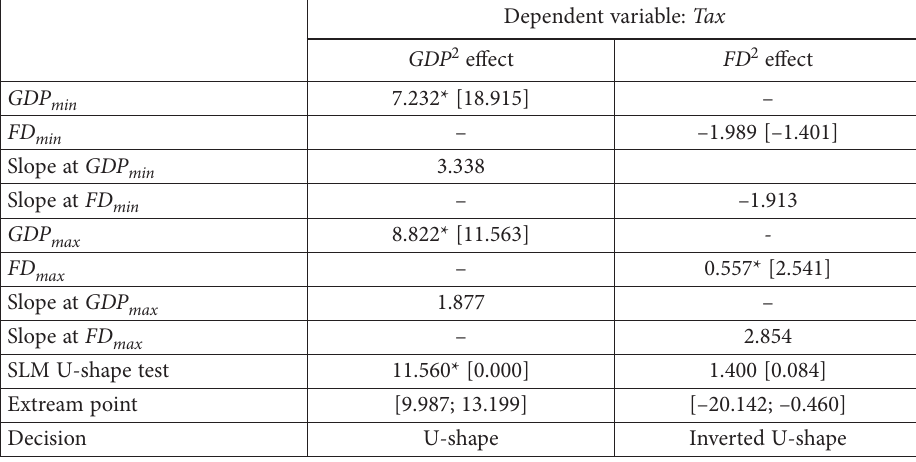
Table 15. Estimates of SLM U-shape